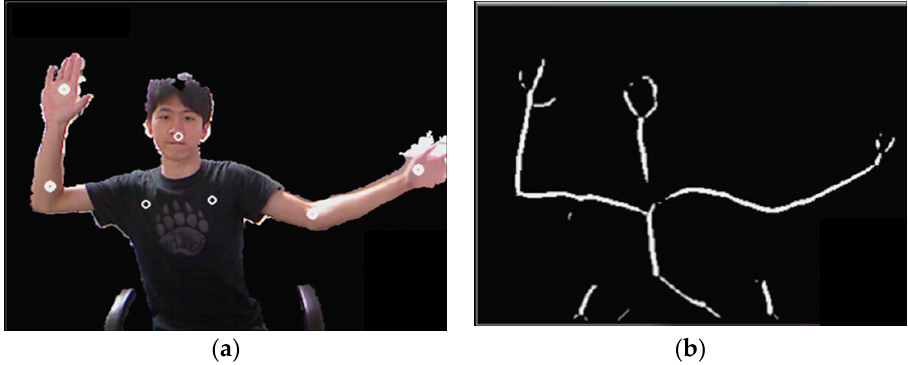
Figure 8. Results before and after skeletonizing: ( a ) before skeletonizing and ( b ) after skeletonizing.